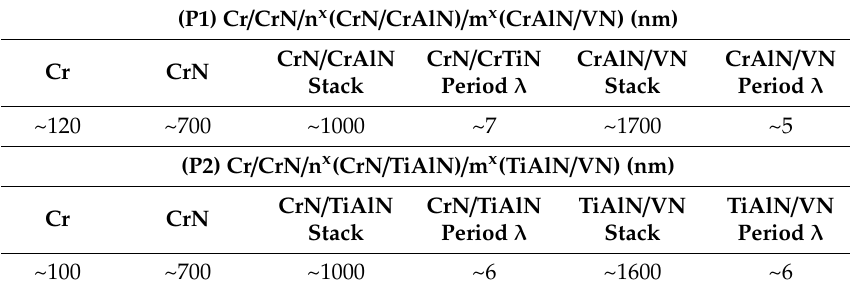
Figure 5. STEM / HAADF images of cross-section microstructure of top of P1 ( a,b ) and P2( c,d ) hybrid coatings with accompanying profiles presenting distribution of Cr, Al, Ti and V. Table 2. P1 and P2 multilayer coatings characteristics measured from STEM / HAADF images and EDS profiles.